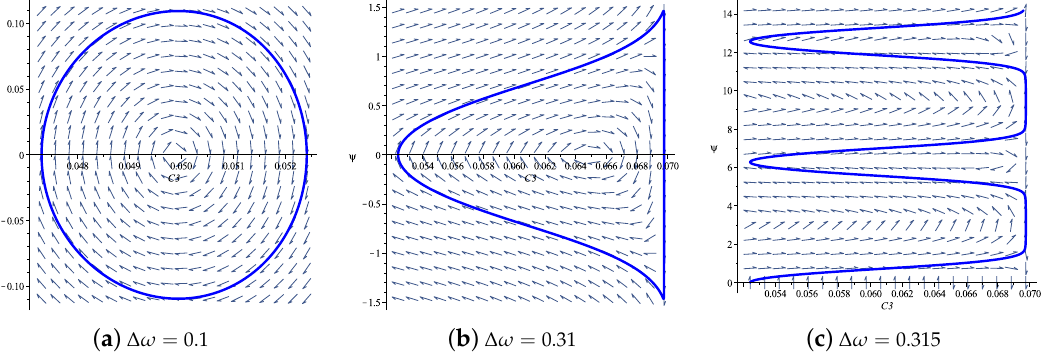
Figure 4. Phase portraits of the dynamical system of Equations (24)–(28) in ( C 3 , ψ ) variables for the triad from Table 1 (case (a)). Positive increasing